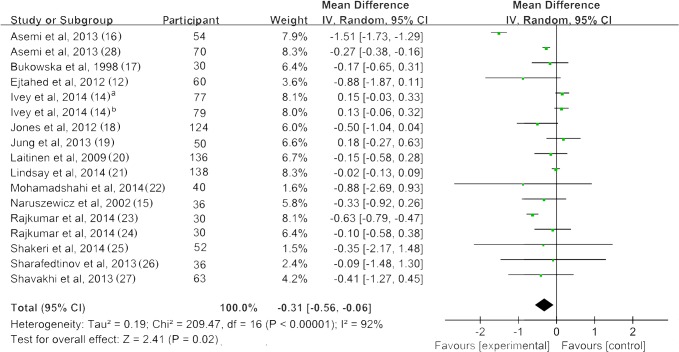
Forest plot of randomized controlled trials comparing the effect of probiotics on fasting blood glucose with placebo/comparator.Weighted mean differences (95% CIs) for fasting blood glucose are shown. Pooled estimates (diamonds) calculated by the random effects method. IV, inverse variance.